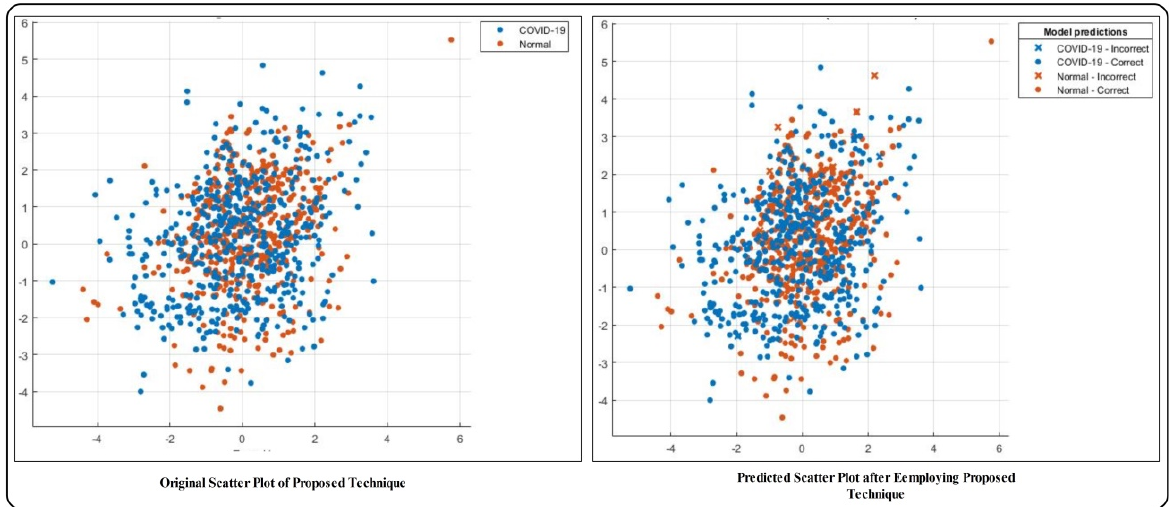
Figure 6. Scatter plot of true classes and predicted classes by MC-SVM using the proposed technique.